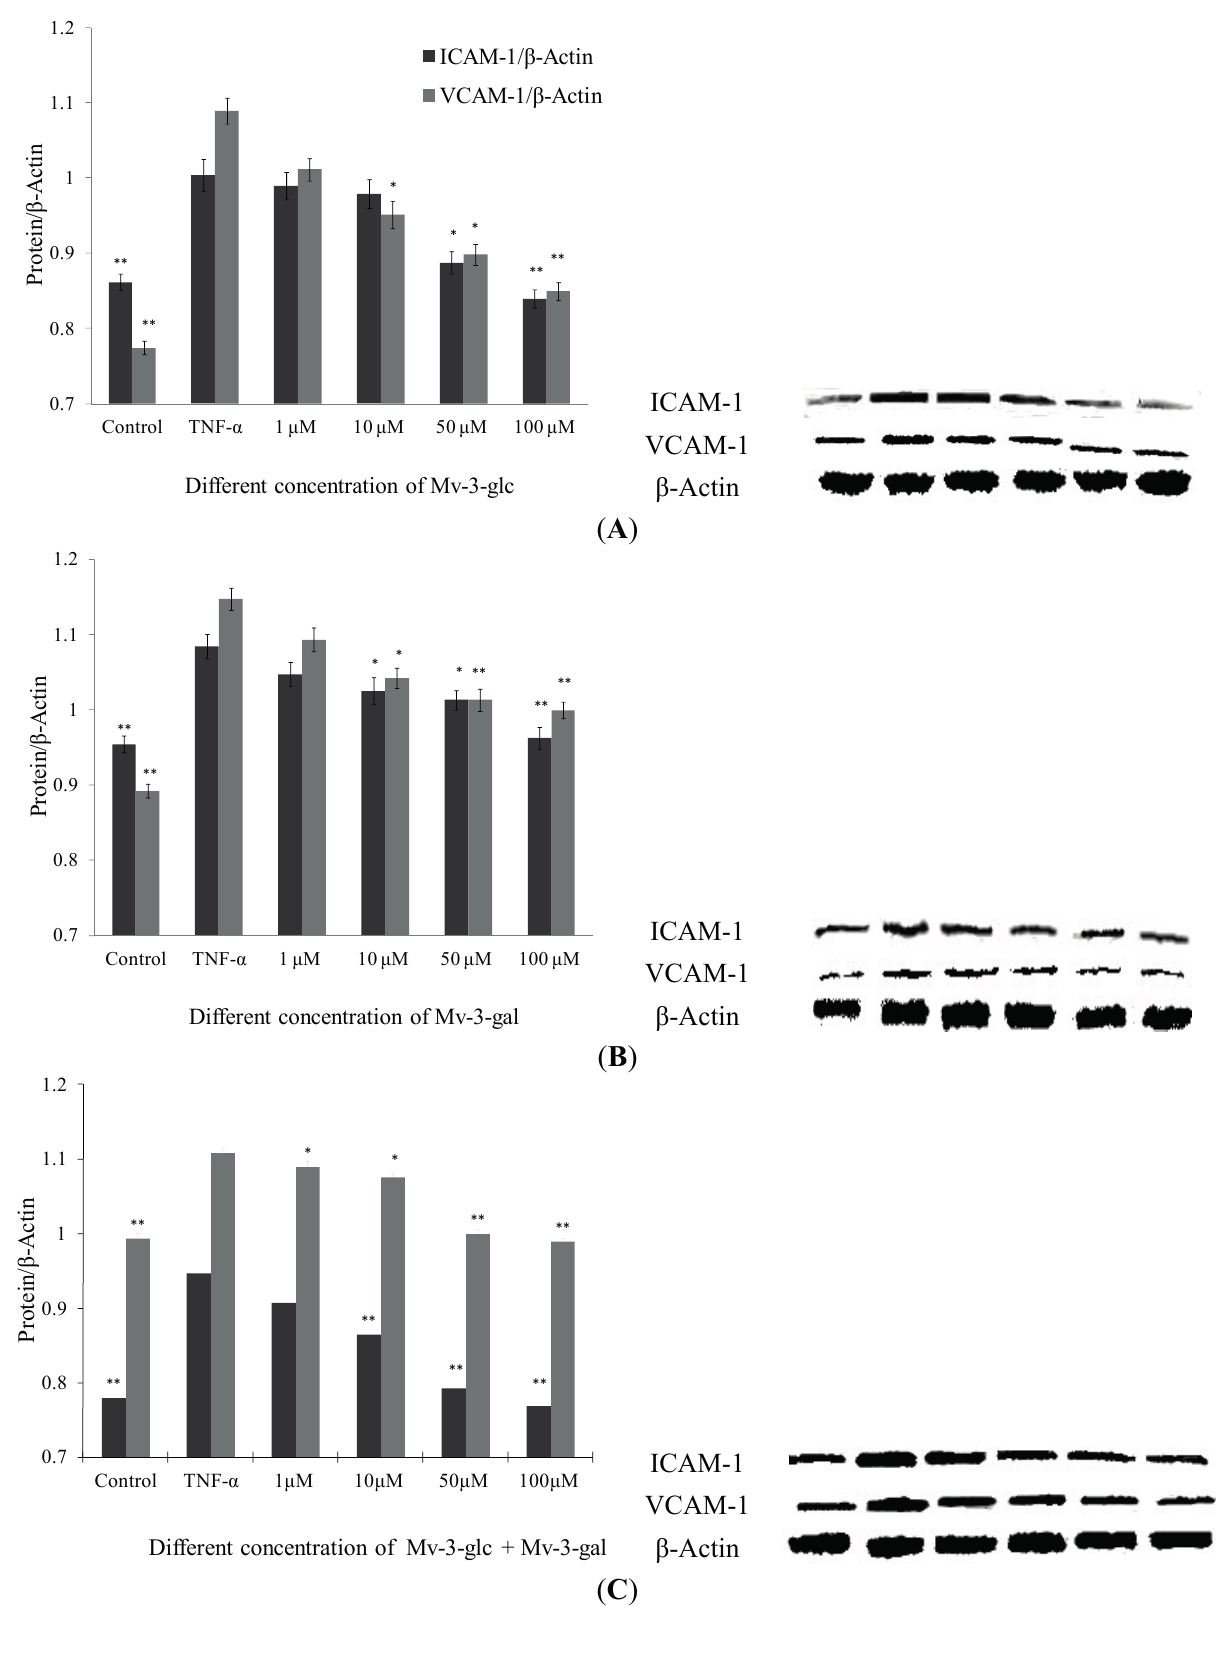
Figure 2. Effects of Mv-3-glc ( A ), Mv-3-gal ( B ), and their mixture (Mv-3-glc + Mv-3-ga) ( C ) on TNF- α -induced ICAM-1 and VCAM-1 protein expression. * and ** indicate p < 0.05 and p < 0.01 respectively compared to TNF- α